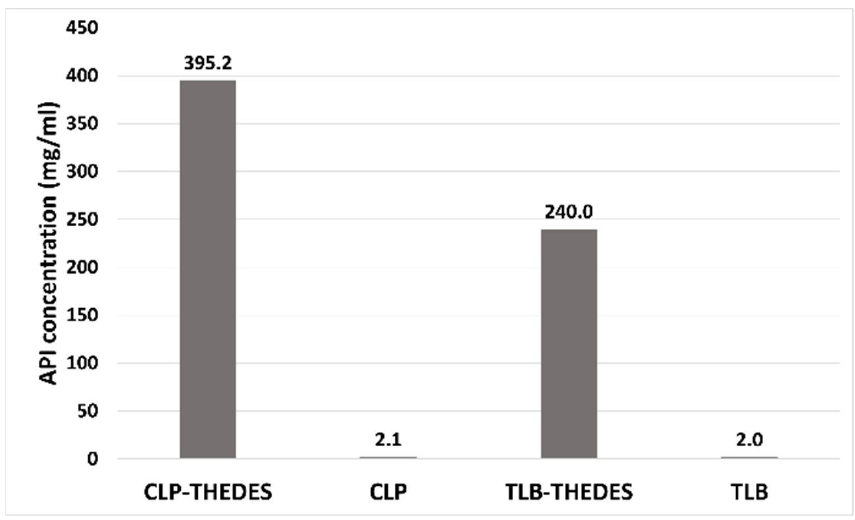
Figure 8. Solubility of the THELES and the crystalline APIs in PBS (pH = 7.4) buffer. Permeability studies were done for 240 min with eight sampling points. Results showed that the percentage of permeability of CLP and TLB in the THELES had the same profile, along the 240 min, as the percentage of permeability of the crystalline APIs (Figure 9). At 240 min, the percentage of permeability for crystalline CLP and CLP-THELES was 51.4% and 51.6%, respectively. For TLB, the percentage of permeability was 41.1% and 52.7% for crystalline TLB and THELES-TLB, respectively.